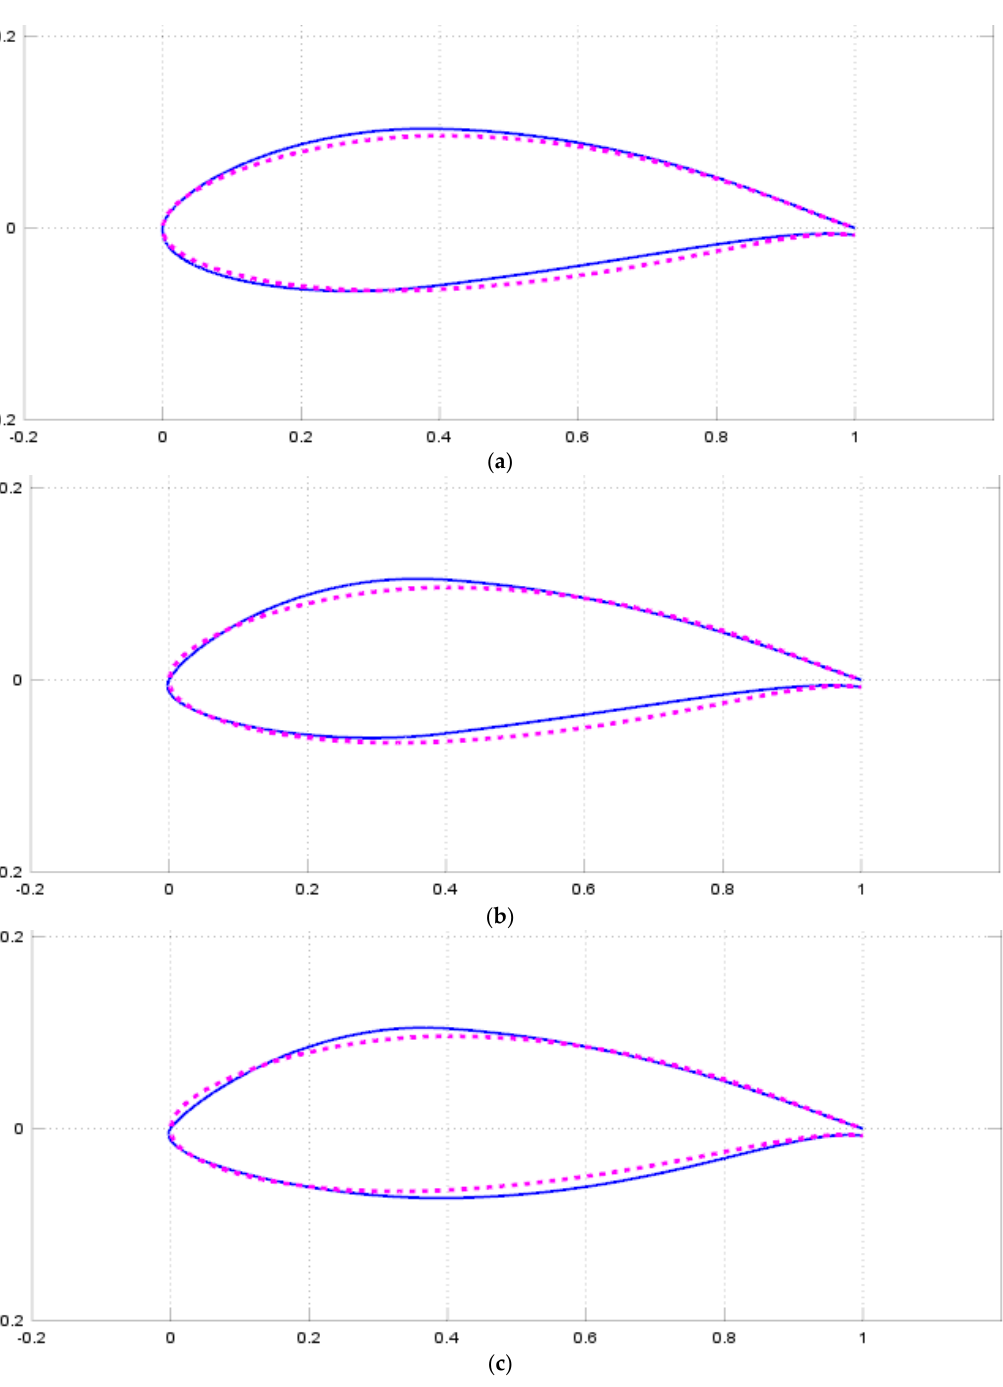
Figure 10. Optimized airfoil shapes for L/C = 3, for the points indicated by full arrows in Figure 9 ( a ) Point 1; ( b ) Point 2; ( c ) Point 3 (Figure 8), red dotted line: original, blue solid line: optimized (note that vertical scale is larger than horizontal scale).